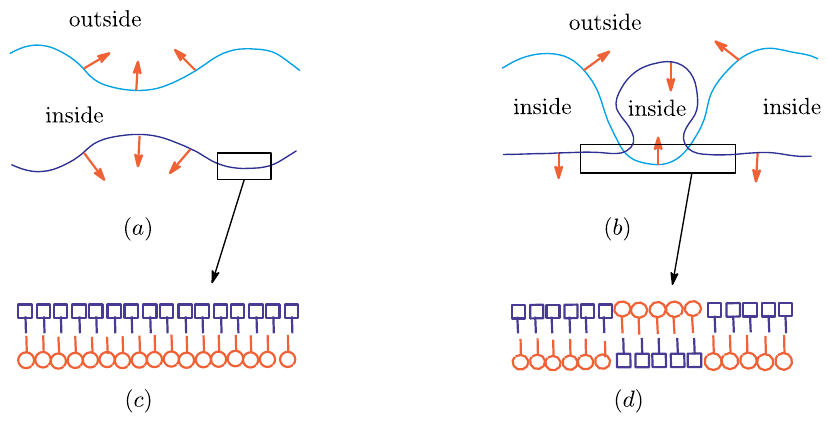
Figure 1. A membrane in aqueous solution separates the solution into two regions; inside and outside. ( a ) Self-avoiding surface with unit normal vectors n ; ( b ) self-intersecting surface with n ; ( c ) lipid bilayer structure of membranes, where the symbols of lipids for inner and outer layers are drawn differently; and ( d ) a partly inverted